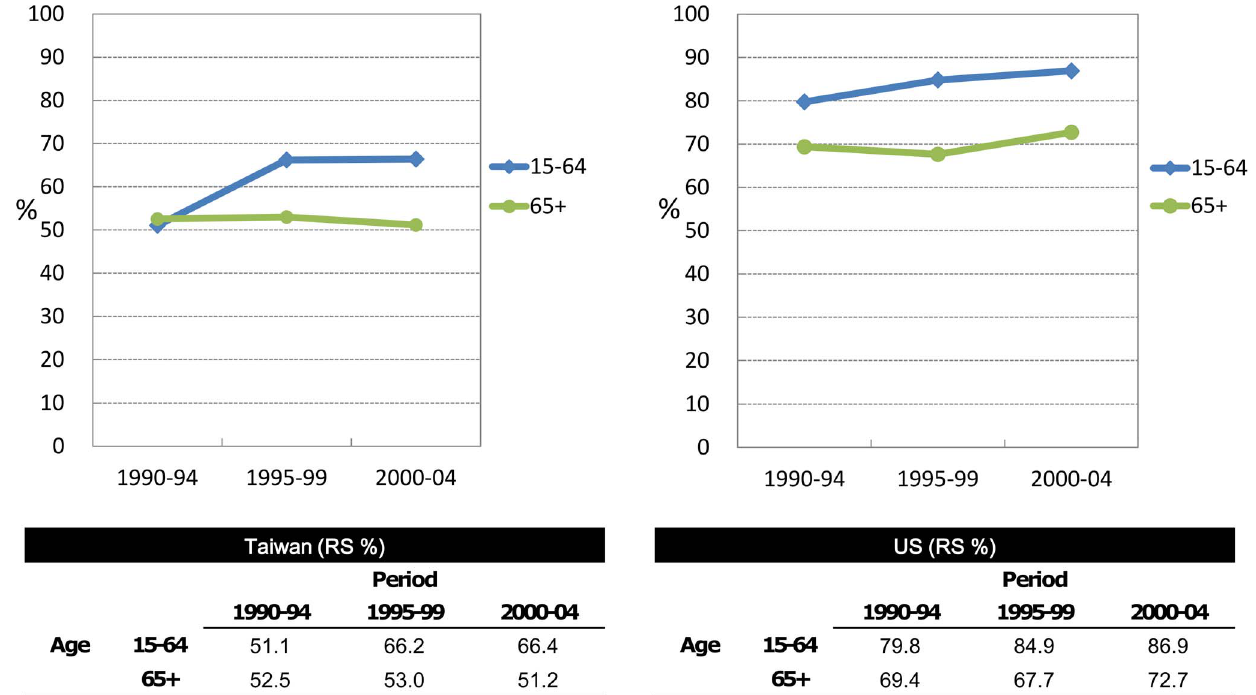
Figure 3. The 5-year relative survival estimates (%) of patients with CLL in different time periods among Taiwanese and the US patients. doi:10.1371/journal.pone.0062930.g003 PLOS ONE |